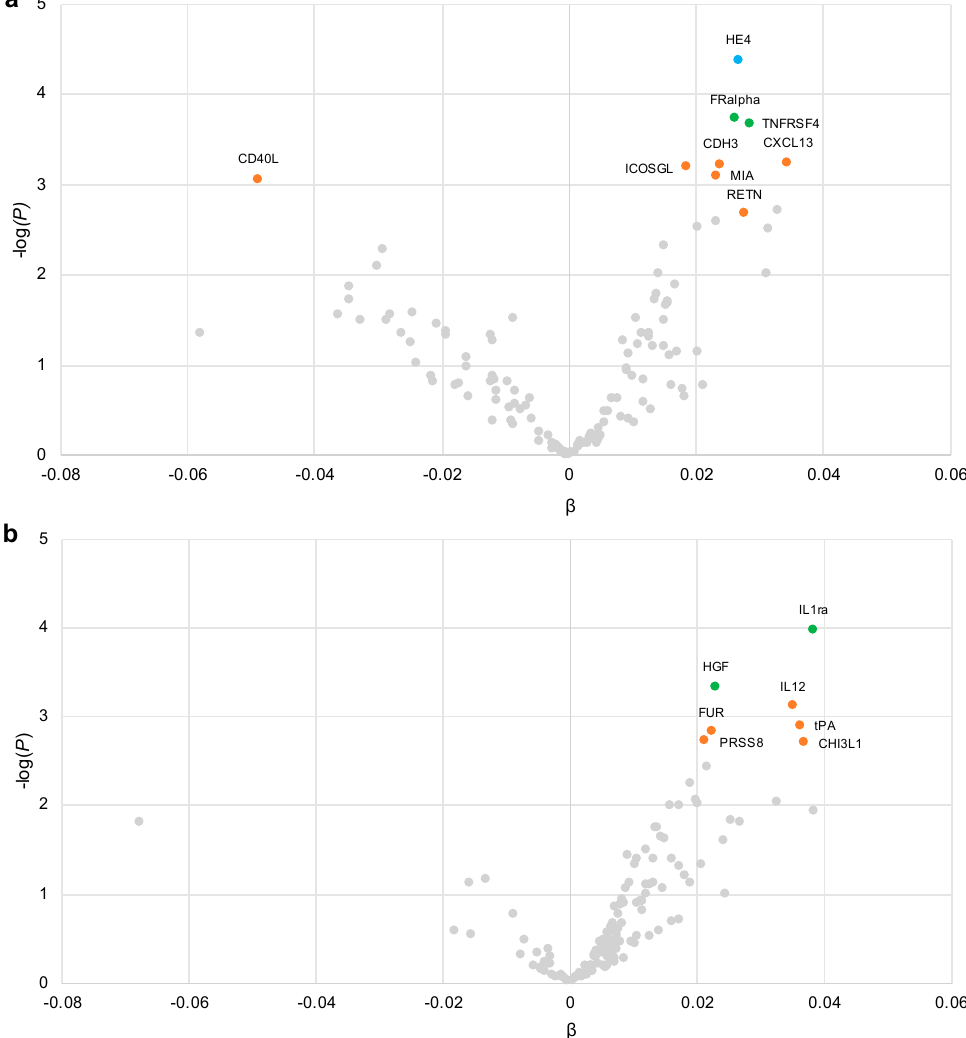
Figure 1. Volcano plot of associations between ( a ) added sugar intake (standardized) and ( b ) SSB intake (log transformed and standardized) and 136 plasma proteins in full sample analysis ( n = 3351–4382). Linear regressions were adjusted for age, sex, season, screening date, total energy intake, education, smoking, alcohol and LTPA. Blue, TSIR replicated at α 1 < FDR0.05; green, TSIR replicated at α 1 < 0.01; orange, TSIR replicated at α 1 < 0.05; grey, not TSIR replicated. FDR, false discovery rate; LTPA, leisure time physical activity; SSB, sugar-sweetened beverage; TSIR, two-step iterative resampling.